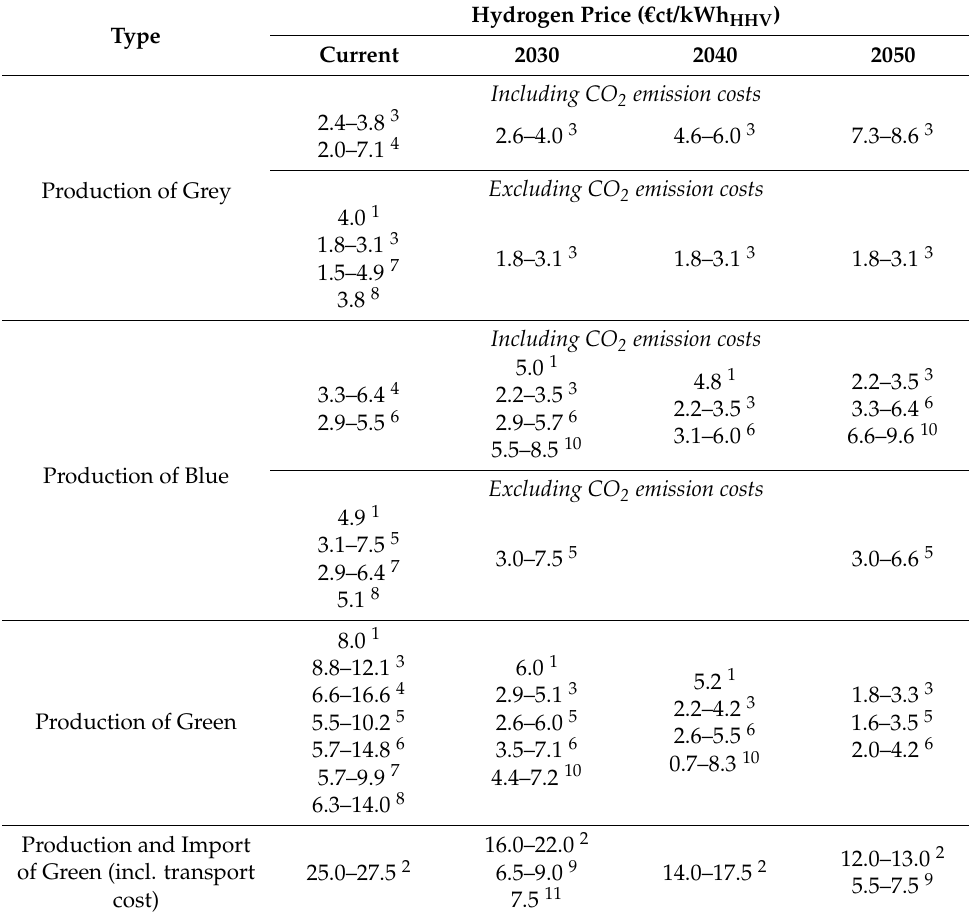
Table 6. Production price comparison for different hydrogen types until